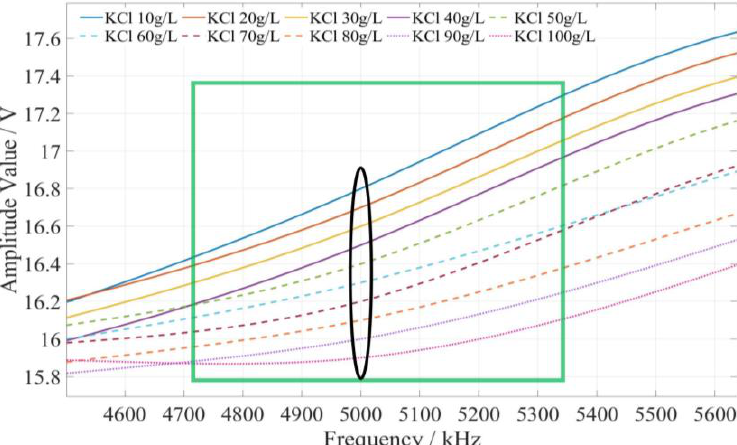
Figure 10. The amplitude–frequency characteristic curve of the KCl fertilizer solution under the excitation signal of 4710~5430 kHz.